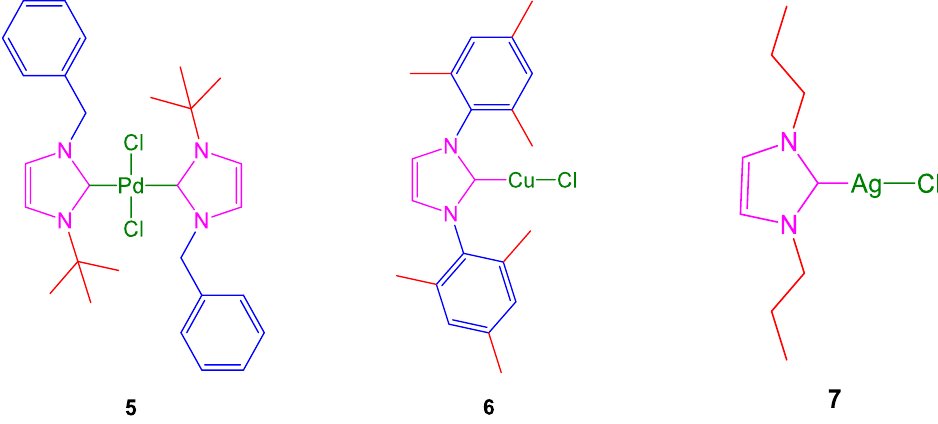
Figure 4. Structures of metal complexes of N -heterocyclic carbene compounds ( 5 – 7 ).